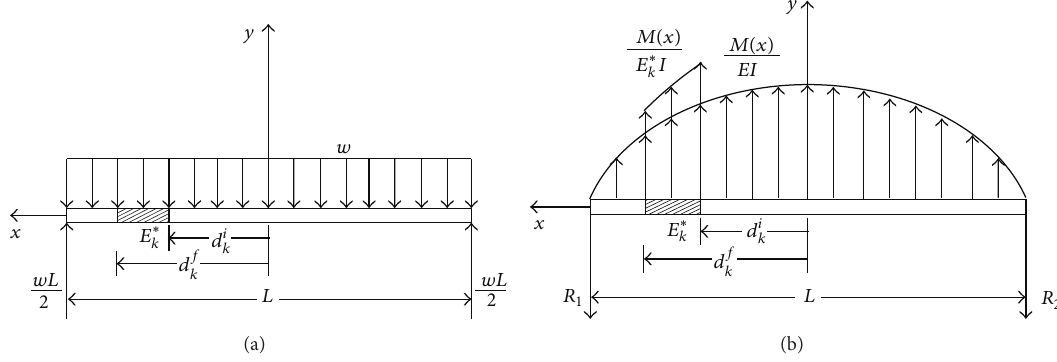
Figure 1: Schematic showing (a) simply supported beam with uniformly distributed load and (b) loading on conjugate